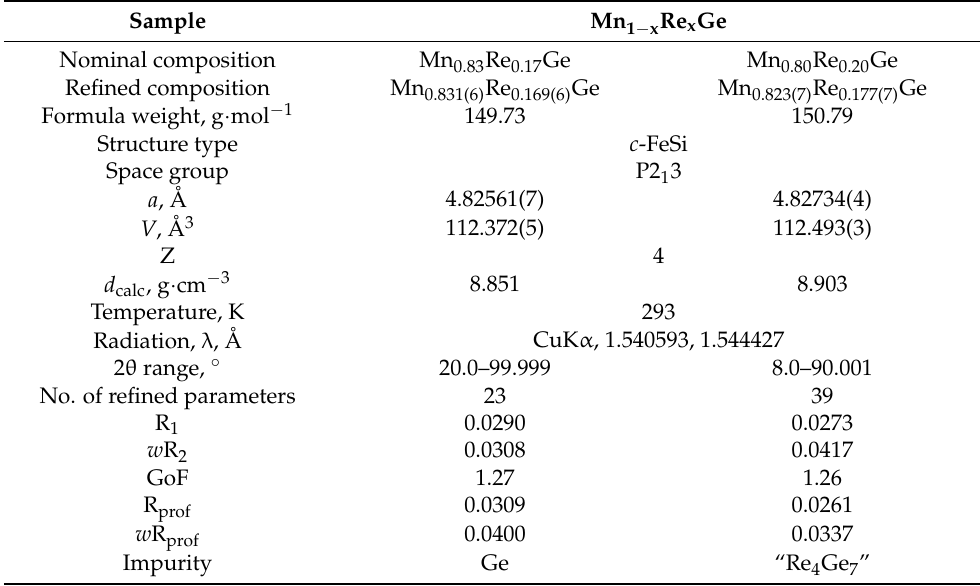
Crystallographic data and structure refinement parameters for the Mn 1 − x Re x Ge powder samples.